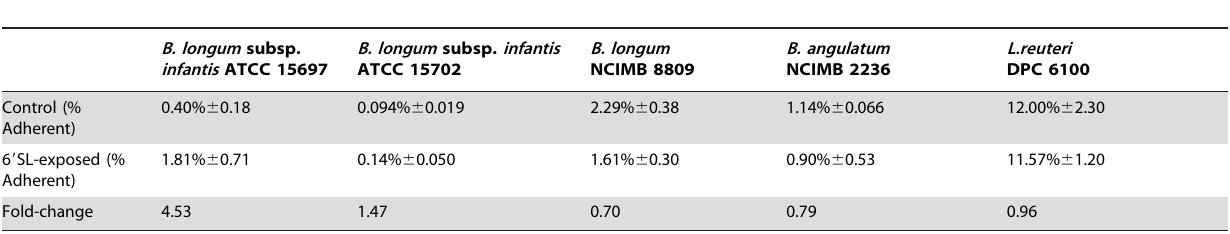
Table 1. Screen of commensal strains for increased adherence to HT-29 cells following exposure to 6 9 sialyllactose.